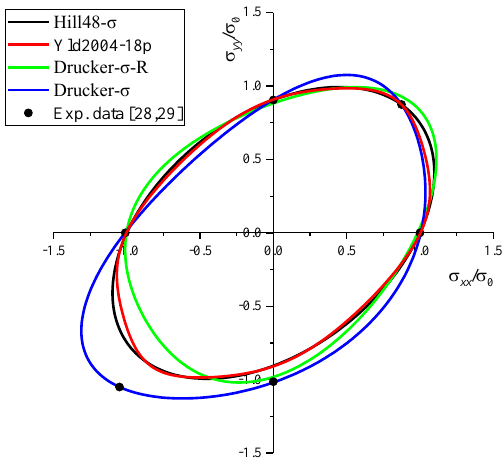
Figure 2. Yield surfaces with four yield functions for AA 2008-T4 sheet. Ducker- σ -R is determined by Equation (40), while Ducker- σ is determined by Equation (41). The biaxial compressive stress shown here is obtained by ( σ c 0 + 2 σ c 45 + σ c 90 ) /4.